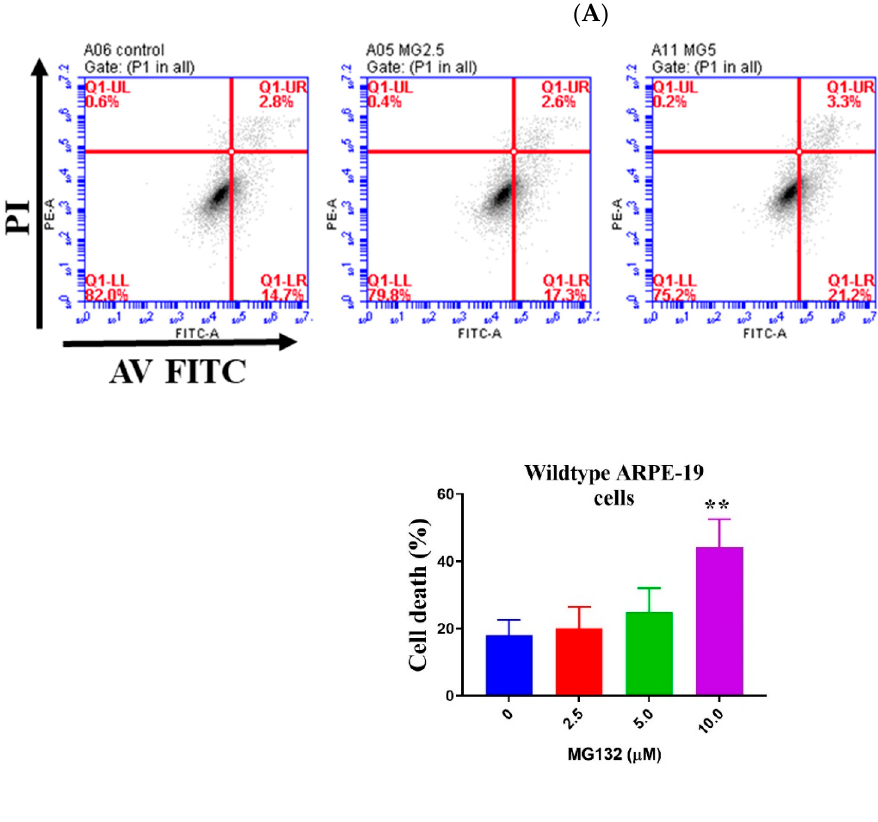
Figure 6. Effect of MG132 on proteasome inhibition and apoptosis in ARPE-19 cells. ( A ) Proteasome activity declines dose-dependently in cells treated with MG132 for 5 h. ( B ) Annexin V-FITC/PI staining to assess cell death after treatment with MG132 or vehicle (control) for 5 h. Data represent the mean (+ SD) of 3 independent experiments of 3 replicates each. Statistical analysis using one-way ANOVA followed by Dunnett’s multiple comparison test. ** p < 0.01, *** p < 0.001, significant difference relative to the controls.